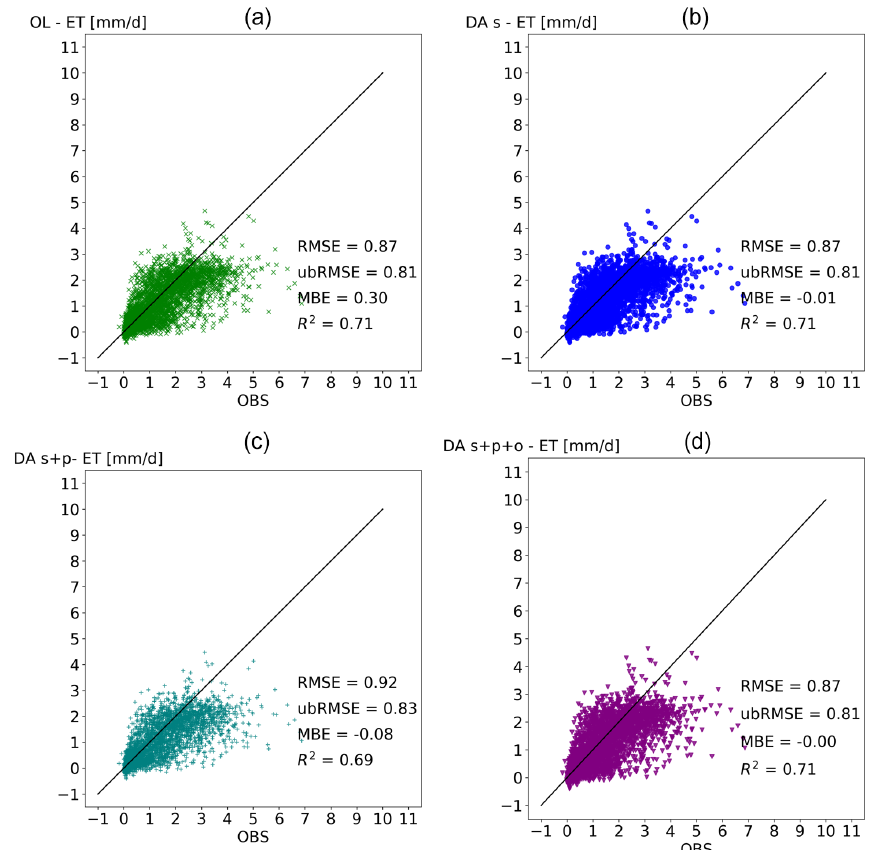
Figure 7. Correlation diagrams for observed (OBS) and simulated evapotranspiration (ET) in millimeter per day [mm/d]. Each marker shows one daily average. Panel (a) shows open loop (OL), panel (b) shows data assimilation of state variable (DA_s), panel (c) shows data assimilation of state and parameters (DA_s + p), and panel (d) shows data assimilation of state and parameters including organic matter (DA_s + p + o). Each diagram shows root mean square error (RMSE), unbiased root mean square error (ubRMSE), mean bias error (MBE), and squared correlation coefficient ( R 2